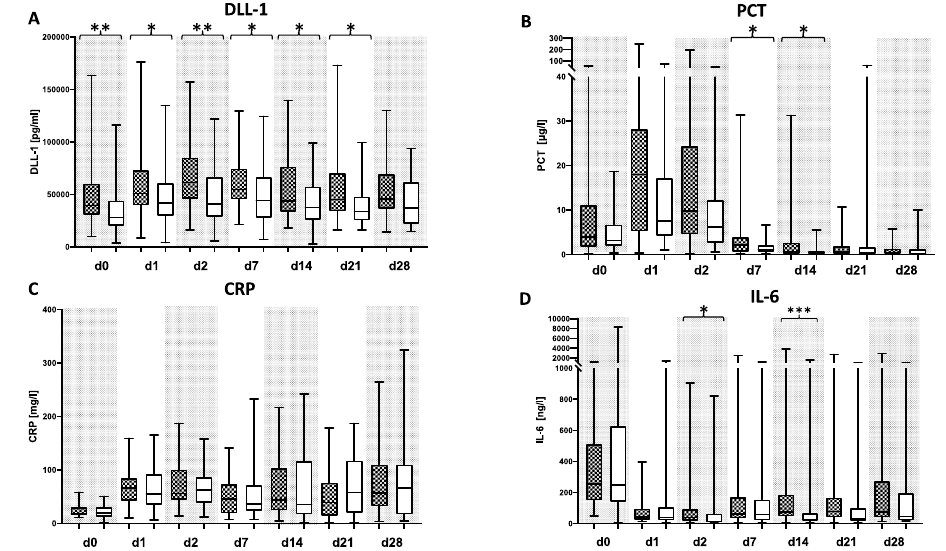
Figure 2. Delta-like Canonical notch ligand 1 (DLL1) for the recognition of a bacterial infection following liver transplantation (LTX). Plasma concentrations of ( A ) Delta-like Canonical notch ligand 1 (DLL1), ( B ) procalcitonin (PCT), ( C ) C-reactive protein (CRP), and ( D ) interleukin (IL-)6 were measured in patients following LTX with a bacterial infection (black-checkered box) or without any bacterial findings (white box). Plasma samples were collected directly after LTX and within the following 28 days afterward on the indicated day. Data presentation: box plots with median, 25th percentile and 75th percentile in the box, as well as with the 10th and 90th percentiles at the end of the whiskers. Symbols of significance: p < 0.05 *, p < 0.01 **, p < 0.001 ***.